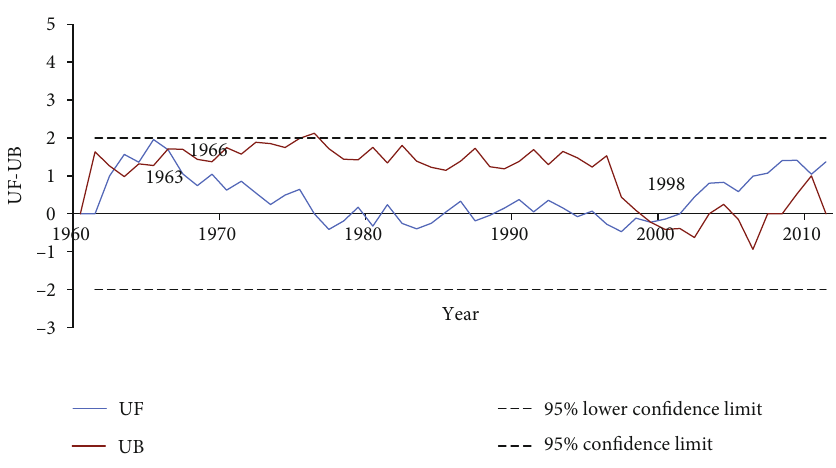
Figure 3: The M-K diagnosis of uneven coe ffi